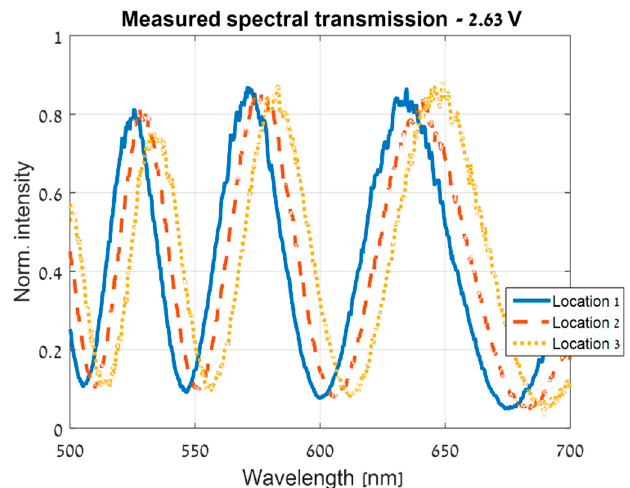
Figure 9. The ST measured with an applied voltage of 2.63 V, at three different locations on the CS-MUSI’s LCC. The non-uniform cell gap causes the ST to shift as the LCC’s retardance changes.